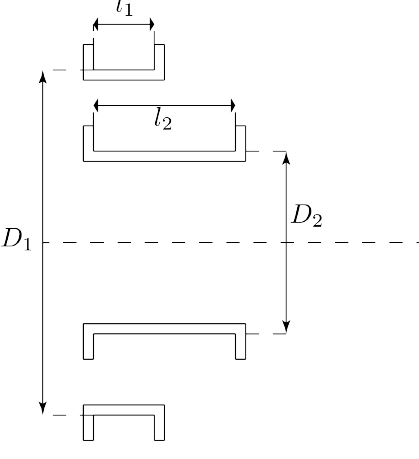
Figure 4. Axial section of a loop-coil set. Table 1. Dimensions of the coils